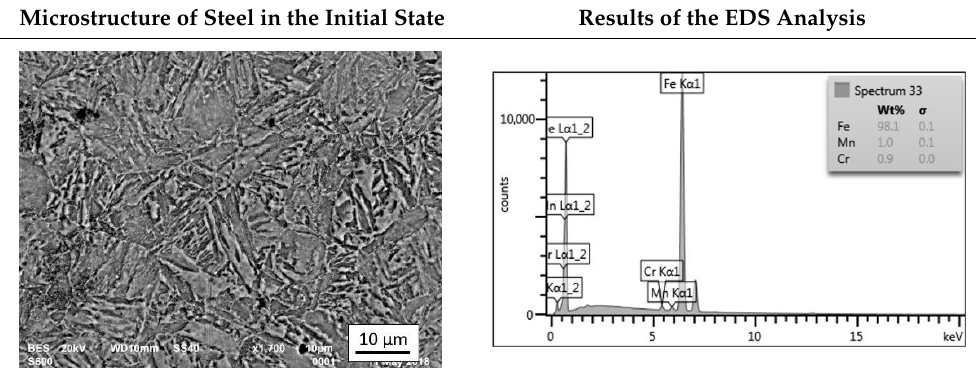
Table 4. Microstructure of steel in its initial state along with the results of the EDS analysis.